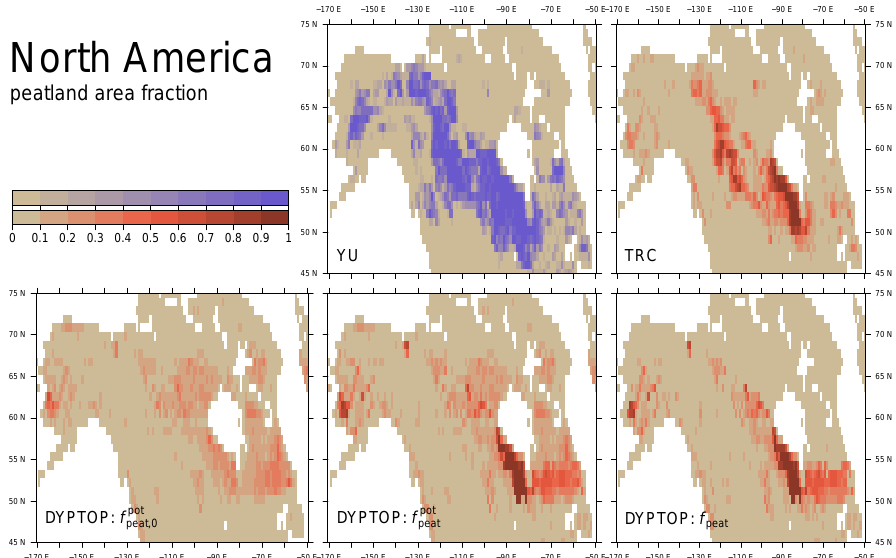
Figure 8. Observed and simulated peatland area fraction in North America. Top row: observed, YU is based on Yu et al. (2010), TRC is based on Tarnocai et al. (2009). Original YU data delineate grid cells with a significant peatland cover fraction ( > 5%). Original binary data on 0.05 ◦ × 0.05 ◦ are regridded to represent the fractional area with significant peatland cover fraction on the 1 ◦ × 1 ◦ grid. This information is not directly comparable to other panels and is therefore illustrated with a distinct colour key. Bottom row: simulated, f pot peatland area fraction, considering hydrological suitability without the peatland-water table position feedback, f pot peat is the potential peatland area fraction, considering hydrological suitability including the peatland-water table position feedback; f peat is the simulated actual peatland area fraction, taking account of the peatland establishment criteria (pt crit ) and peat expansion and